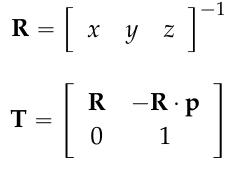
Figure 5. Coordinate transformation and curve derivation along the hand surface at the candidate location: ( a ) transformed image of 3D hand surface points with respect to the reference frame; ( b ) derivation schematic of the curve along the hand surface.